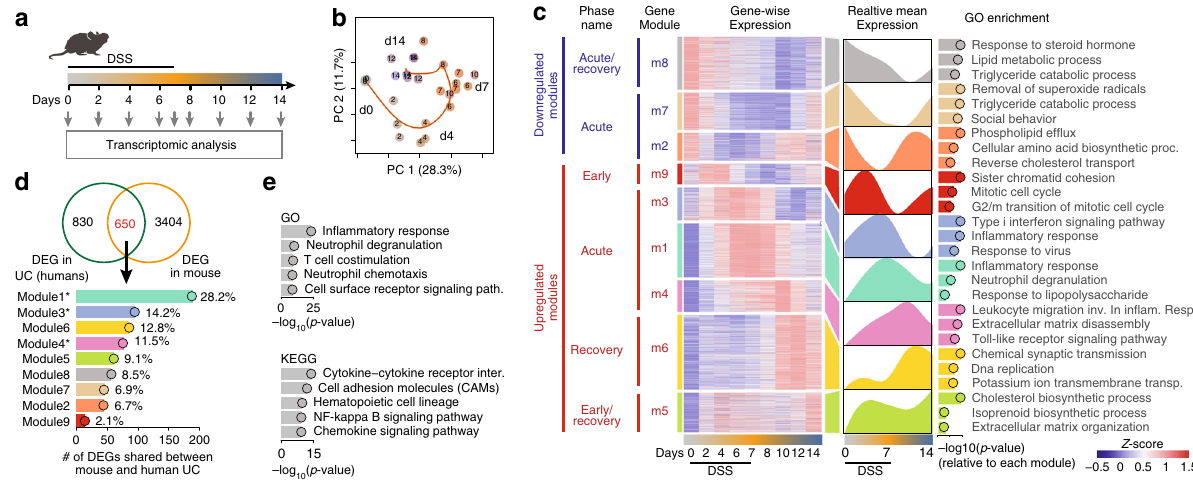
Fig. 2 Unbiased characterization of the DSS colitis reveals conserved in fl ammatory signature between mice and humans. a Schematic illustration of the experimental design. Mice received DSS in drinking water for 7 days, after which the treatment was replaced with water. Samples were collected at indicated time points. b PCA on differentially expressed gene counts. Samples were color-coded according to their respective day of collection (from gray to orange to blue). The percentage of variance explained by the respective principal component is indicated in parenthesis. c Clustered heatmap of all differentially expressed genes (left). The mean expression of each gene module is shown (right). Functional annotation of genes in each cluster was done based on Gene Ontology (GO) enrichment. Only the top three enriched processes are shown, sorted by p -value. d Venn diagram comparing the list of DEGs in treatment-naive UC and the DEGs identi fi ed in mouse DSS colitis (upper). Among the 650 genes shared among those lists (in red), the number and percentage of genes were found in each module identi fi ed in our mouse data set (lower). Modules highlighted in bold are the ones enriched for in fl ammatory terms in ( c ). e GO and KEGG enrichment analysis out of the 650 shared genes identi fi ed in ( d ), sorted by p